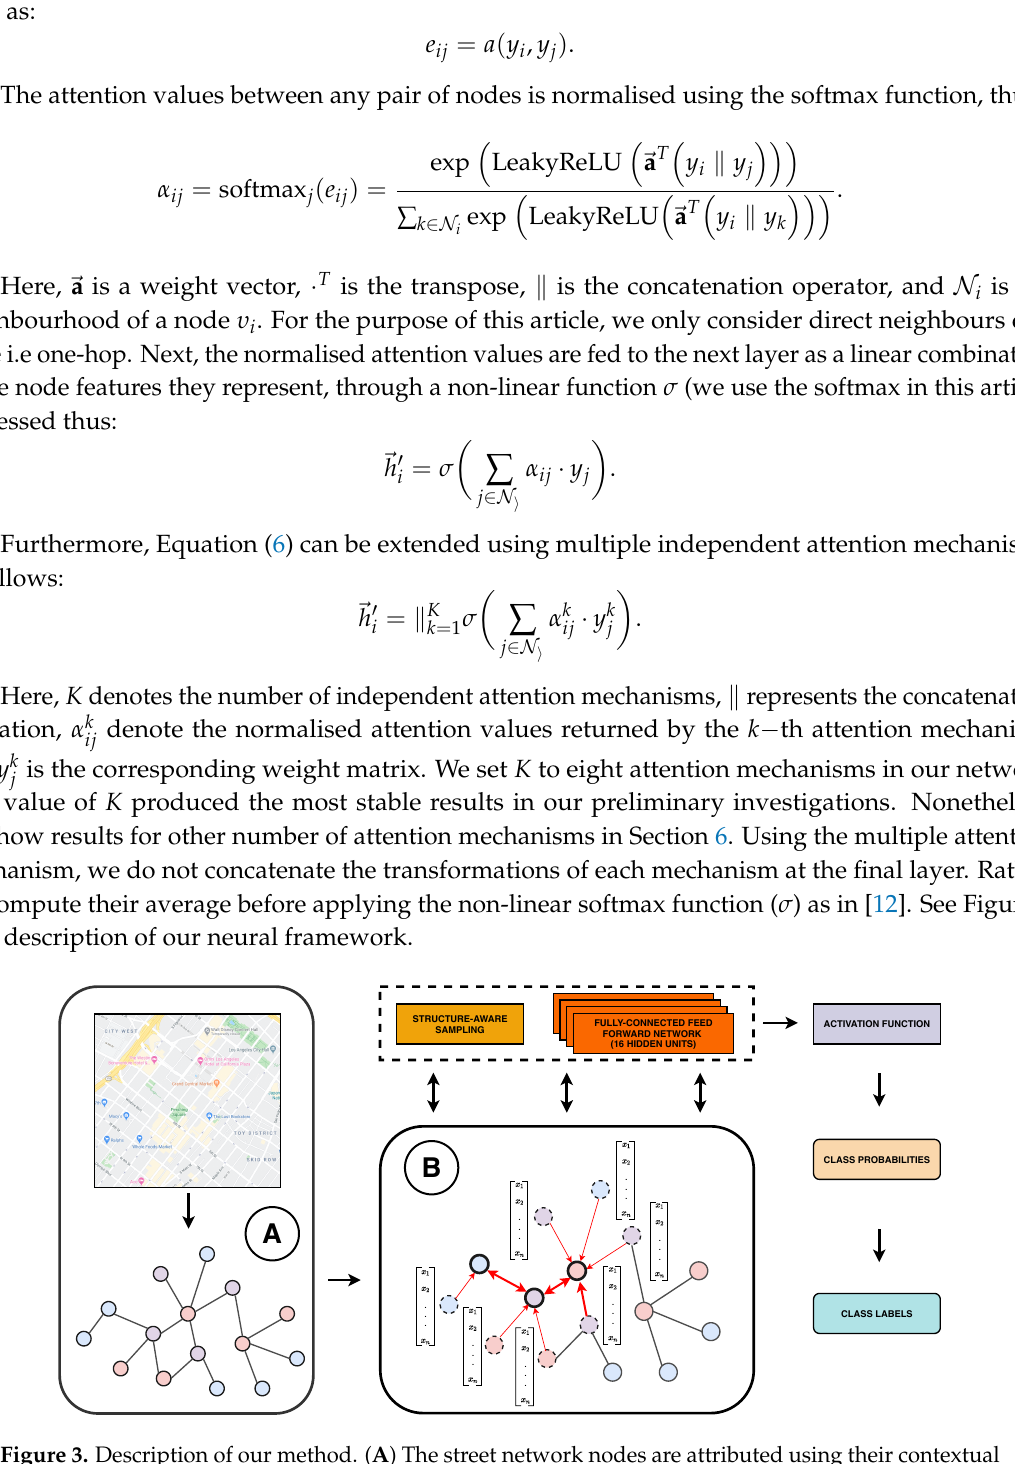
Figure 3. Description of our method. ( A ) The street network nodes are attributed using their contextual information. ( B ) The proposed sampling technique is used to select nodes based on their position in the graph. Nodes with bold lines are the sampled ones and nodes with dotted lines are their neighbours. The weight of the red lines indicates the strength of attention given to the information from a